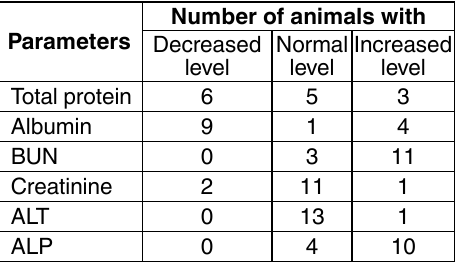
table 6. Number CPV infected dogs with various alterations in different serum biochemical parameters Parameters